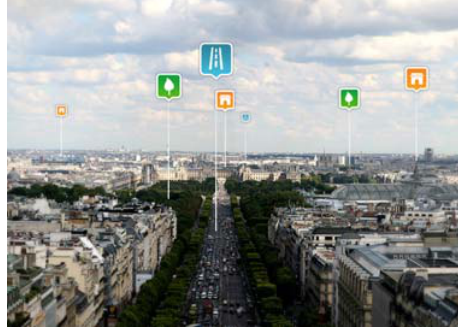
Fig. 8. View from “ Arc de Triomphe, Paris (France)” with pictogram information balloon.